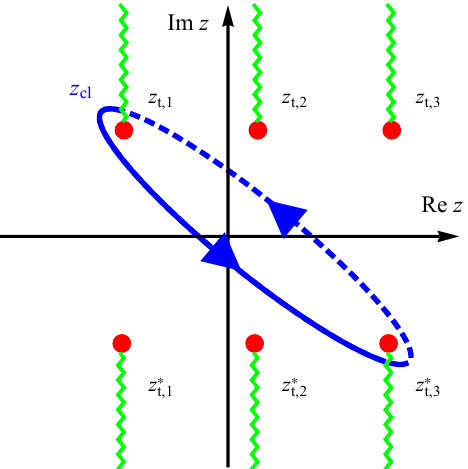
Figure 5 . (color online) A non-trivial classical path z cl (blue line) enclosing a single pair of turning points z t ,i and z ∗ (red dots). The wavy green lines represent branch cuts. The dashing of the blue t ,j line distinguishes Riemann sheets; thick (dashed) for the first (second) Riemann sheet such that p p d z cl / d u = + Q [ z cl ] ( − Q [ z cl ])